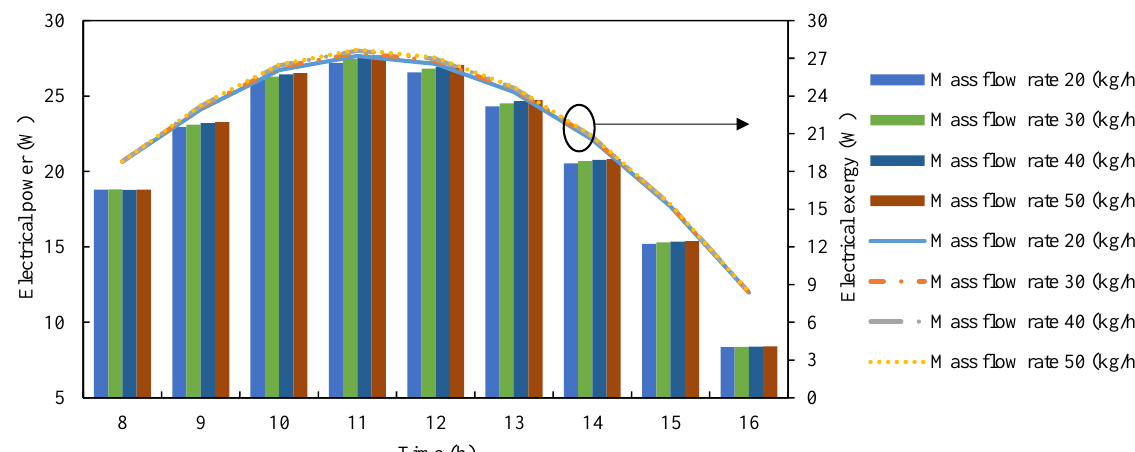
Fig. 9. Temporal variations of the electrical power and rate of electrical exergy at different mass flow rates